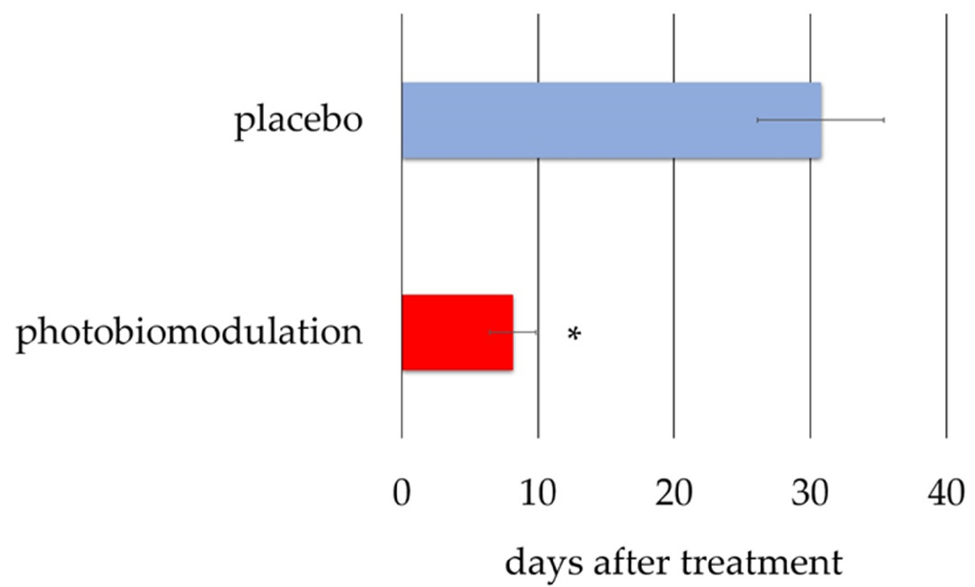
Figure 4. Effect of photobiomodulation and placebo treatment on aphtha’s healing. Photobiomodulation therapy induced a statistical significative reduction of the healing time (* p < 0.05).